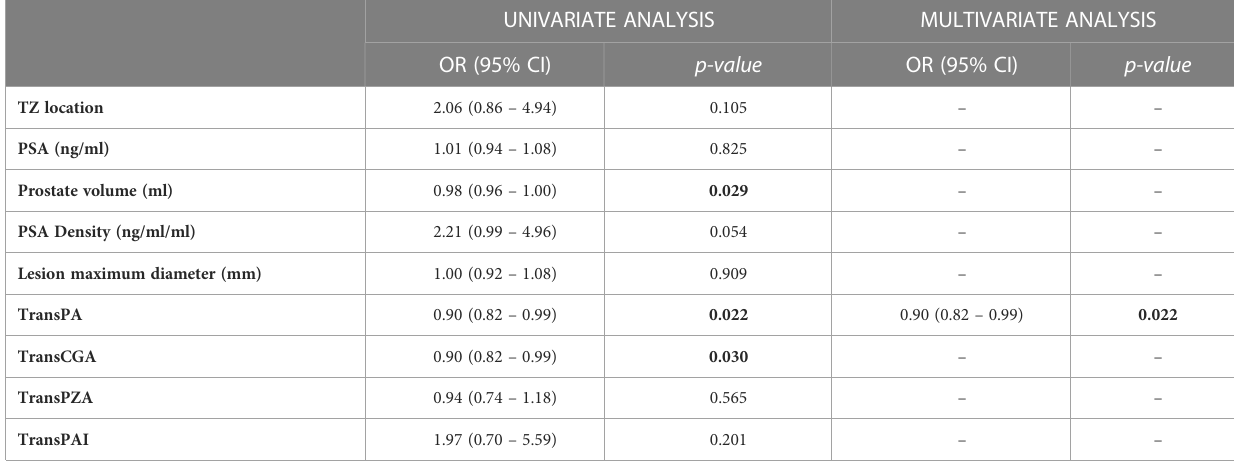
TABLE 4 Univariate and multivariate analyses to predict the presence of csPCa (GGS ≥ 2) at fusion-TB in the overall population of patients with PI- RADS 3